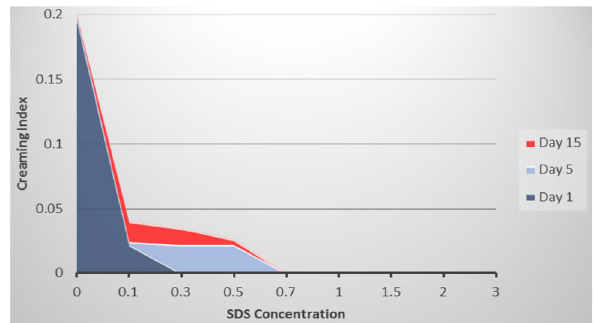
Fig. 14 Creaming index versus SDS concentrations in different